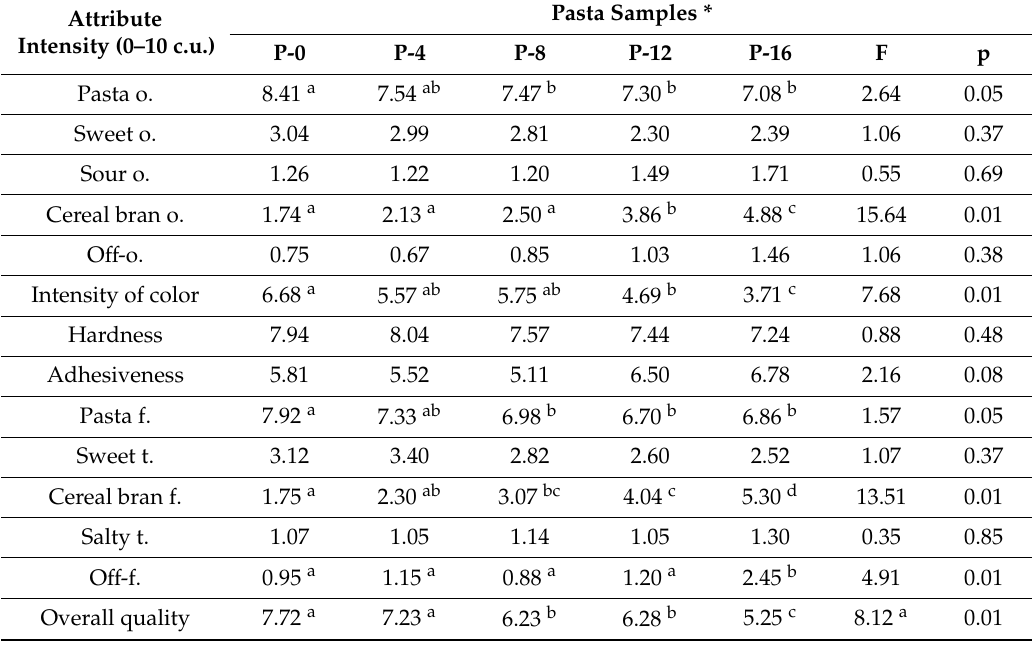
Table 4. Results of variance analysis of data obtained in QDP method (Quantitative Descriptive Profile) for cooked pasta ( n = 20). Pasta Samples * Attribute Intensity (0–10 c.u.) P-0 P-4 P-8 Pasta Profile) for cooked pasta ( n = 20).